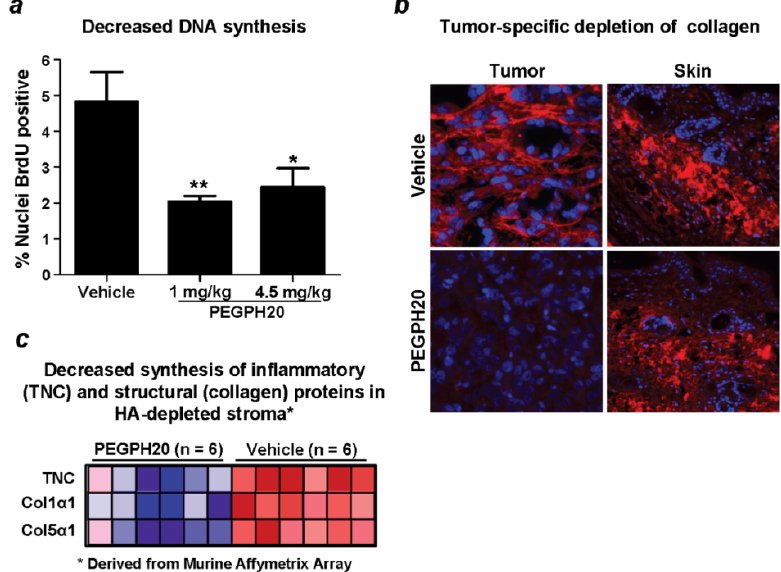
Figure 7. Depletion of HA from the ECM results in decreased DNA synthesis and molecular remodeling of the tumor. Antitumor and stromal-depleting effects are observed after treatment of PC3 (HA +3 ) xenografts with PEGPH20. These include reduced tumor DNA synthesis ( a ); tumor-specific depletion of collagen ( b ); and decreased synthesis of stromal proteins (tenascin C, collagens 1 and 5) ( c ); Experimental details are described in Jiang et al. [13]. Error bars represent SEM of averages from six mice. Reprinted by permission